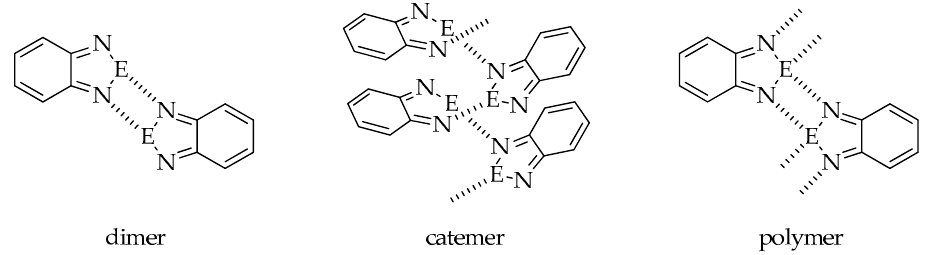
Figure 1. Possible ways of molecule aggregation in crystals of 2,1,3 ‐ benzochalcogenadiazoles (E = S, Se, Te).